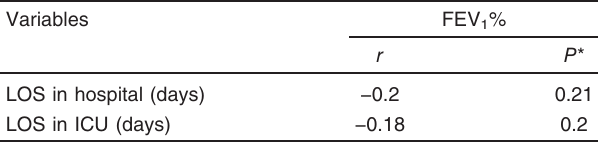
Table 3 Bronchial obstruction level in correlation with patient